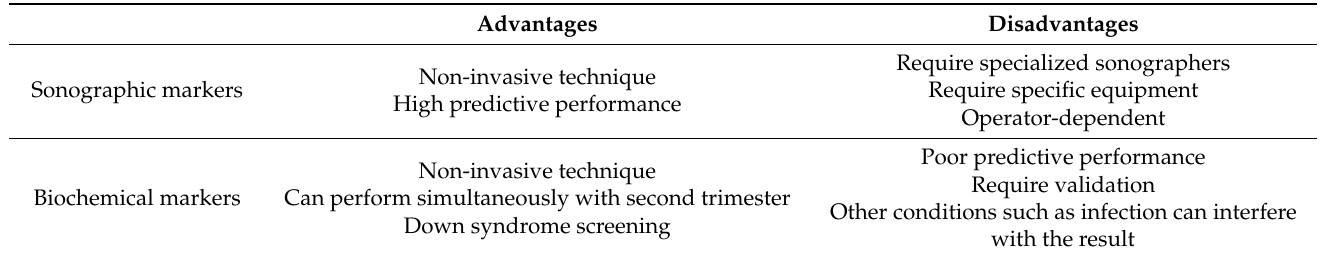
Table 3. Advantages and disadvantages of different biomarkers for the identification of Hb Bart’s hydrops